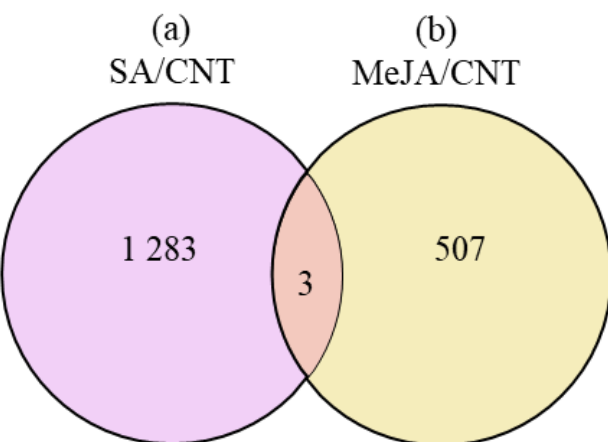
Figure 6. Two-set Venn diagram analysis of salicylic acid (SA) and methyl jasmonate (MeJA)-responsive genes in the juice sacs in vitro. ( a ) A set of 1286 salicylic acid-responsive genes whose expression is more than 2-fold increased by salicylic acid treatment; ( b ) A set of 510 methyl jasmonate-responsive genes whose expression is more than 2-fold decreased by methyl jasmonate treatment. CNT, control.